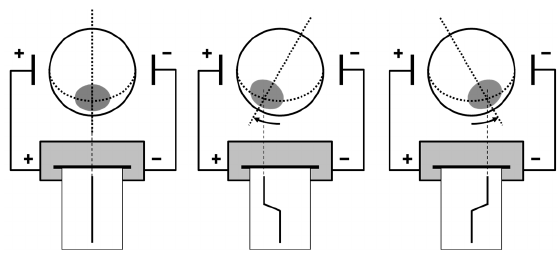
Figure 1. Potential changes according to the eyeball movement for EOG measurement.